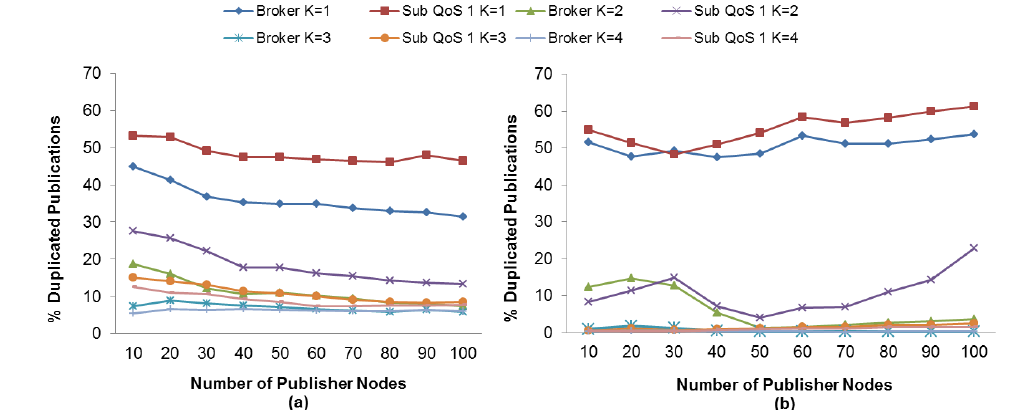
Figure 14. Effect of the number of Publisher nodes on the Duplicated Publications on Broker and Publisher Nodes depending on the K value of for RTO without ( a ) and with ( b ) MAC